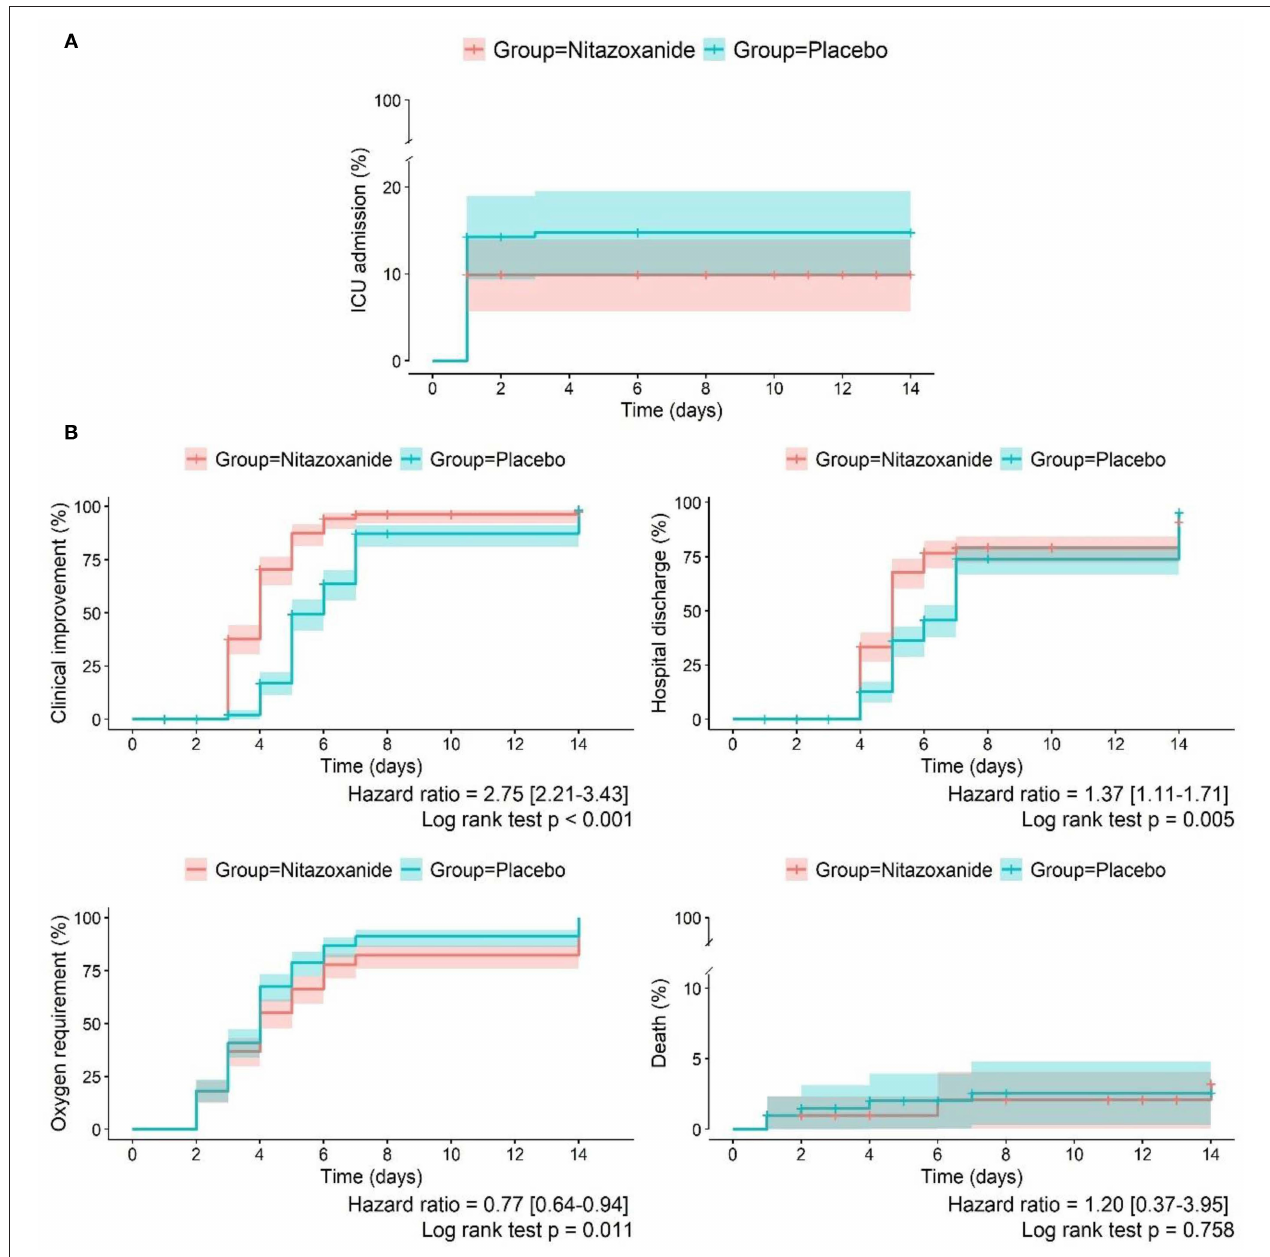
FIGURE 2 | Primary and secondary outcomes in the nitazoxanide and placebo groups at the different time points. (A) Primary outcome: intensive care unit admission. (B) Secondary outcomes: clinical improvement, hospital discharge, oxygen requirement and death in the mITT population treated with nitazoxanide or placebo until day 14. The Kaplan-Meier curves and hazard ratios with corresponding 95% confidence intervals were calculated from a Cox proportional hazards model. mITT, modified intention-to-treat.